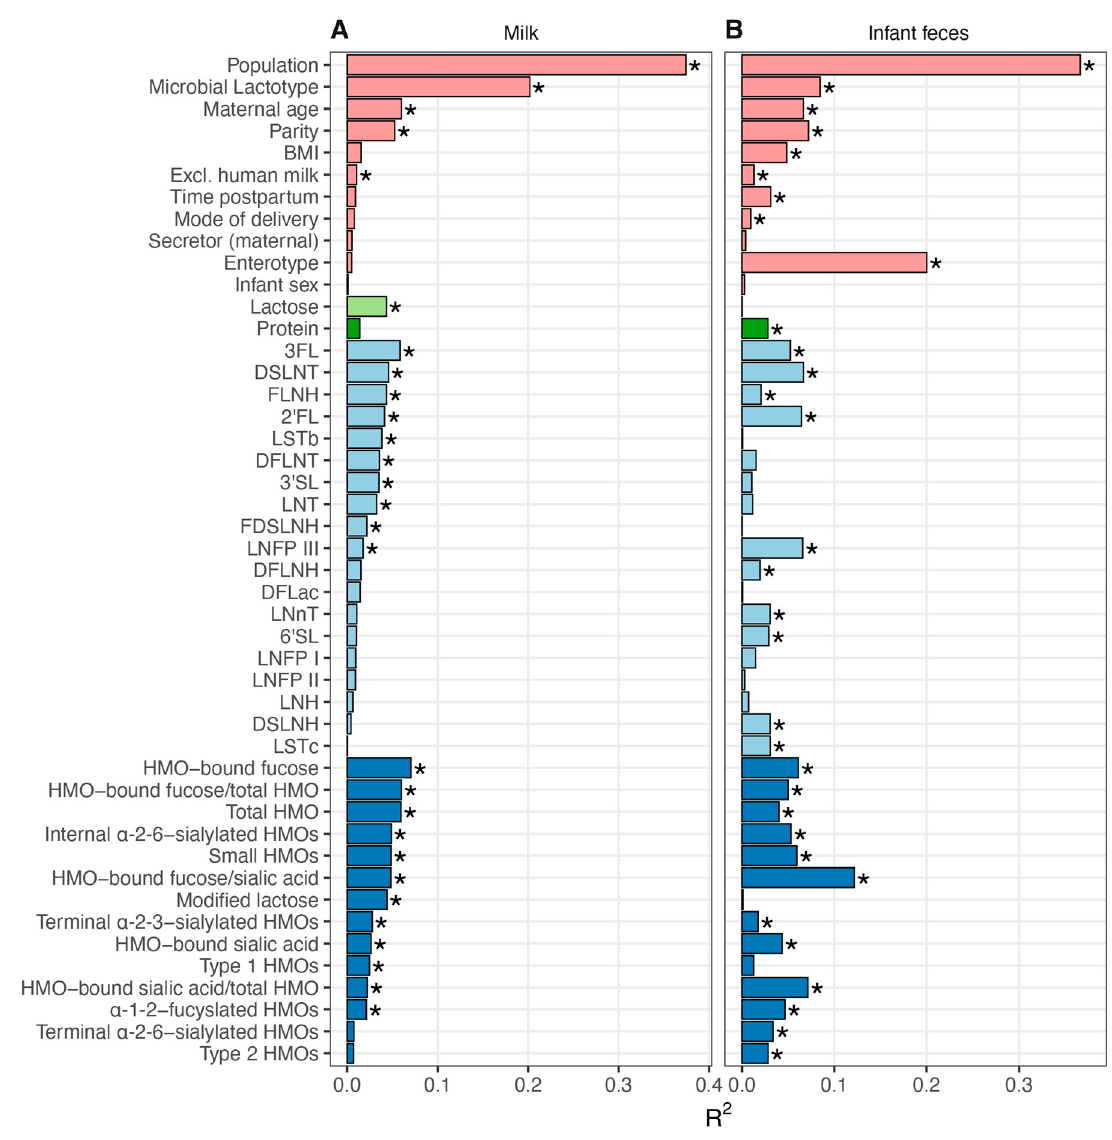
Figure 3. Associations between maternal/infant characteristics, milk factors, and microbial community structures of milk and infant feces. Envfit was used to model maternal and infant characteristics (pink), the concentration of milk lactose (light green), protein (dark green), and HMOs (individual HMOs in light blue, HMO groupings in dark blue) against ( A ) milk and ( B ) infant fecal microbial community structure (Bray − Curtis, NMDS; n = 340). Features along the y-axes in both panels are ordered based on the R 2 values from the milk analysis, sorted within maternal/infant characteristics and milk factor groupings from highest to lowest R 2 . Significant features (FDR p ≤ 0.1) are denoted with an asterisk. 2 ′ -fucosyllactose (2 ′ FL), 3-fucosyllactose (3FL), lacto-N-neotetraose (LNnT), 3 ′ -sialyllactose (3 ′ SL), difucosyllactose (DFlac), 6 ′ -sialyllactose (6 ′ SL), lacto-N-tetraose (LNT), lacto-N-fucopentaose (LNFP) I, LNFP II, LNFP III, sialyl-LNT (LST) b, LSTc, difucosyllacto- LNT (DFLNT), lacto-N-hexaose (LNH), disialyllacto-N-tetraose (DSLNT), fucosyllacto-N-hexaose (FLNH), difucosyllacto- N-hexaose (DFLNH), fucodisialyllacto-lacto-N-hexaose (FDSLNH) and disialyllacto-N-hexaose (DSLNH); small HMOs (2 ′ FL, 3FL, 3 ′ SL, 6 ′ SL, and DFLac), modified lactose (small HMOs and lactose), type 1 HMOs (LNT, LNFP I, LNFP II, LSTb, and DSLNT), type 2 HMOs (LNnT, LNFP III, and LSTc), α -1-2-fucosylated HMOs (2 ′ FL and LNFP I), terminal α -2-6- sialylated HMOs (6 ′ SL and LSTc), internal α -2-6-sialylated HMOs (DSLNT and LSTb), terminal α -2-3-sialylated HMOs (3 ′ SL and DSLNT), ratio of HMO-bound sialic acid (Sia) to total HMOs (HMO-bound sialic acid/total HMOs), ratio of HMO-bound fucose (Fuc) to total HMOs (HMO-bound fucose/total HMOs), and ratio of the ratio of HMO-bound Fuc to HMO-bound Sia (HMO-bound fucose/HMO-bound sialic acid).